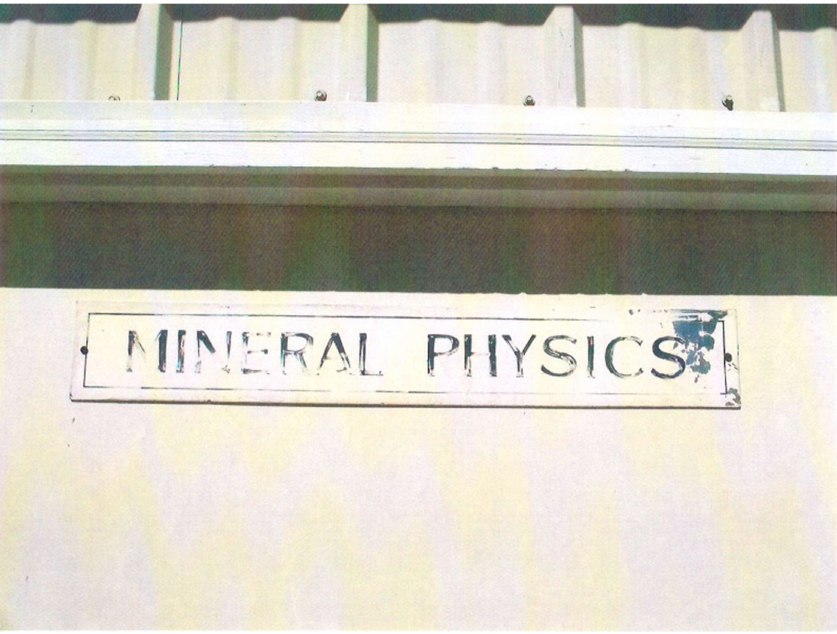
Figure 2. “Mineral Physics” sign from Lamont in 1965. The name proposed by Orson Anderson. The sign and photo were made by Edward Schreiber